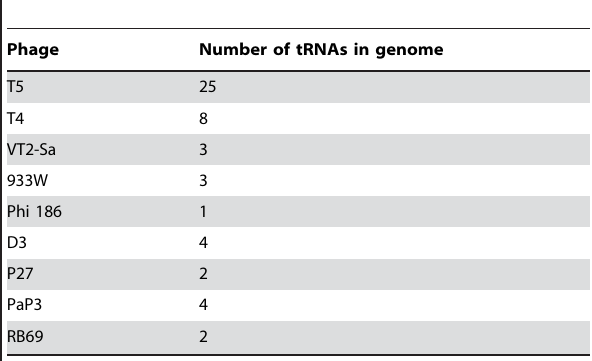
Table 5. The number of tRNA genes in phage